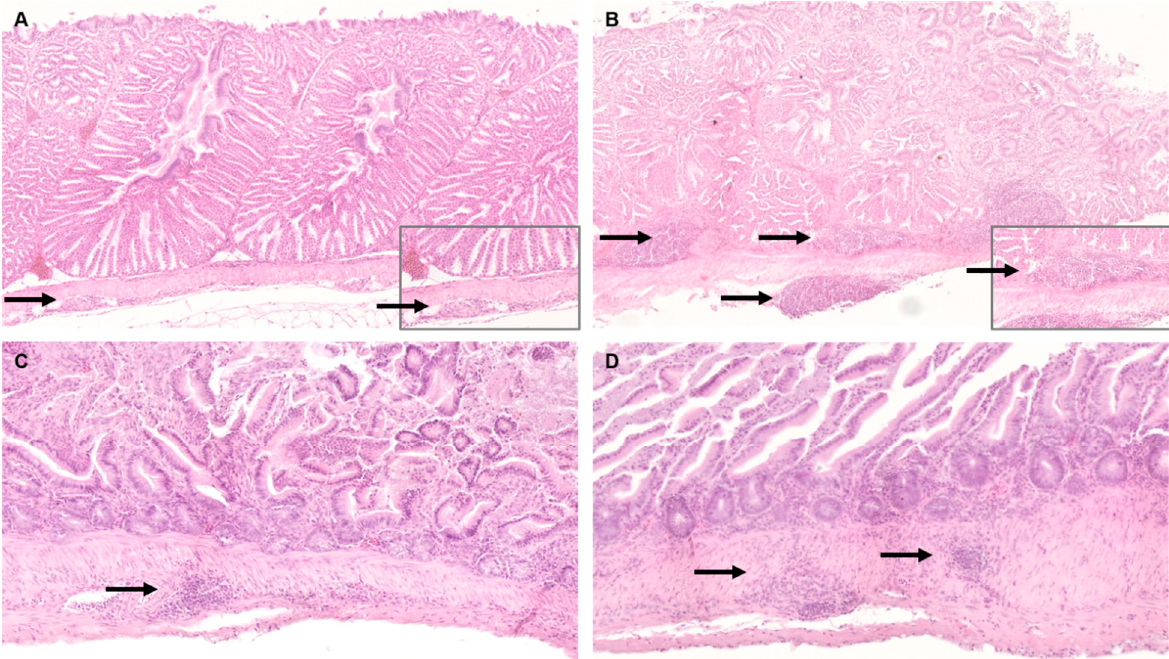
Figure 2. Histology of gastrointestinal tissue of Parrot bornavirus 4 (PaBV-4)-infected adult and juvenile cockatiels. ( A ) Proventriculus of adult cockatiel A 0,1. Mild non-purulent ganglionitis (arrow); original magnification x100, magnification of insert ×400. ( B ) Proventriculus of juvenile cockatiel J 2. Severe non-purulent ganglionitis (arrow), neuritis, and lymphoid hyperplasia; original magnification ×100, magnification of insert ×400. ( C ) Intestine of adult cockatiel E 1,0. Moderate ganglionitis, neuritis, and lymphoid hyperplasia (arrow) and mononuclear infiltration of the lamina propria; original magnification ×100. ( D ) Intestine of juvenile cockatiel J 6. Severe non-purulent ganglionitis, neuritis, and lymphoid hyperplasia (arrow) and mononuclear infiltration of the lamina propria; original magnification ×100; hematoxylin and eosin staining (H&E).